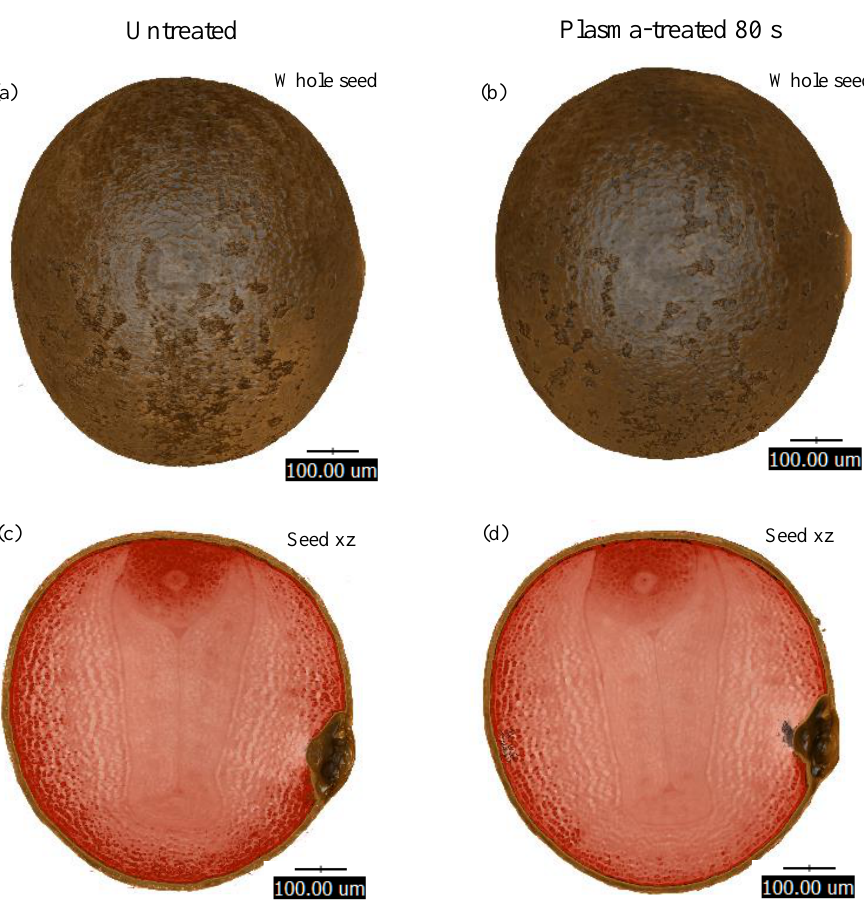
Figure 9. SRXTM image of ( a ) untreated, ( b ) plasma-treated, and cross-section in the xz direction of ( c ) untreated, and ( d ) plasma